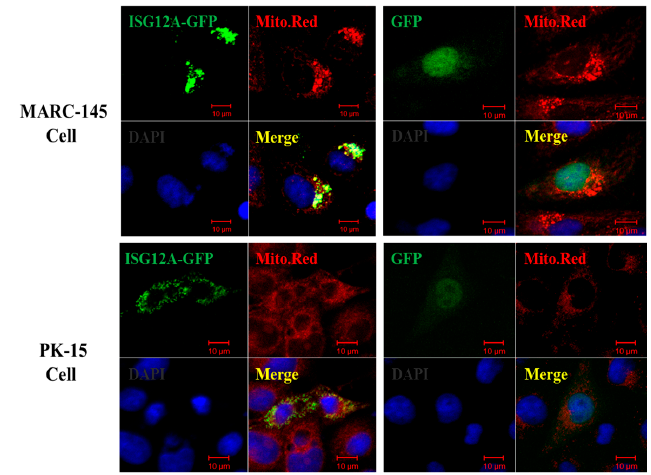
Figure 2. Subcellular localization of porcine ISG12A. MARC-145 or PK-15 cells were transfected with pEGFP-N1-ISG12A (ISG12A-GFP) or pEGFP-N1 (GFP, green) plasmid, and stained with MitoTracker ® Red for mitochondria (Mito. Red) and 4 ′ ,6-diamidino-2-phenylindole (DAPI, blue) for nucleus, Fluorescent images were acquired with a confocal laser scanning microscope (scar bar: 10 µm).